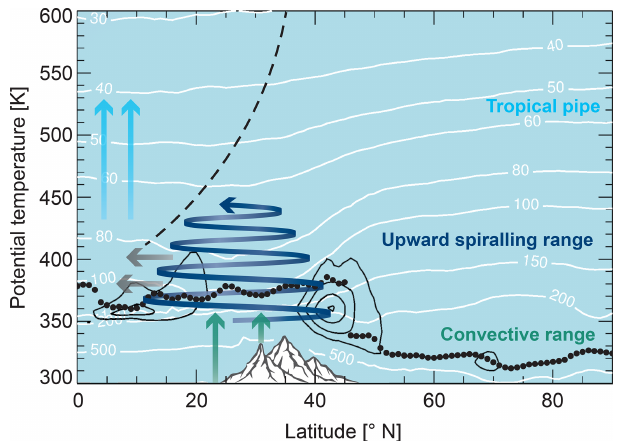
Figure 14. Latitude–theta cross section at about 90 ◦ E. The trans- port of air masses from the region of the Asian monsoon into the tropical pipe occurs in three distinct steps: first, very fast uplift within the convective range up to ∼ 360K within the Asian mon- soon anticyclone and outside in the tropical adjacent regions (within a few days); second, uplift above 360K (up to ∼ 460K) within the upward spiralling range (within a few months); and third, transport within the tropical pipe to altitudes higher than 460K associated with the large-scale Brewer–Dobson circulation (within ∼ 1 year). The thermal tropopause (black dots) and horizontal winds (black lines) are shown. The horizontal winds mark the edge of the anticy- clone at its northern and southern flank. The levels of pressure are marked by thin white lines. Large grey arrows indicate isentropic transport from the Asian monsoon anticyclone into the tropics. The dashed line marks the tropical pipe, which largely isolates tropical air masses from isentropic mixing with mid-latitude air (e.g. Plumb, 1996; Volk et al.,